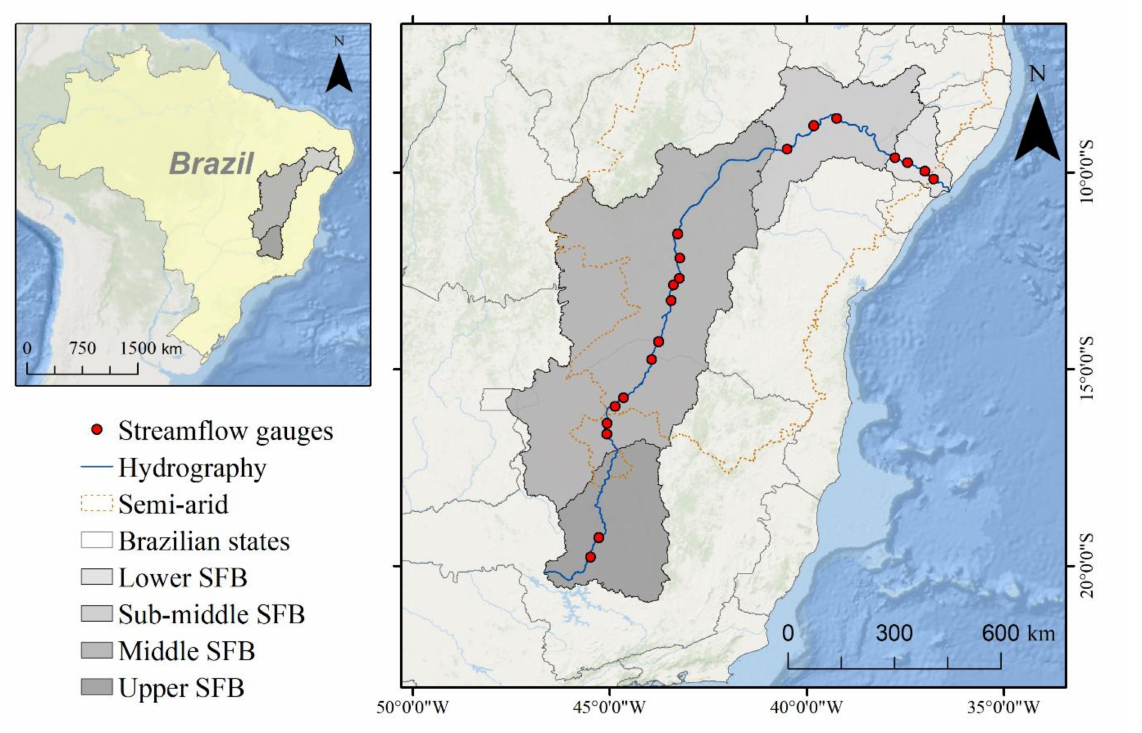
Figure 1. The Sao Francisco River Basin (SFB) location and river gauges along the Sao Francisco River